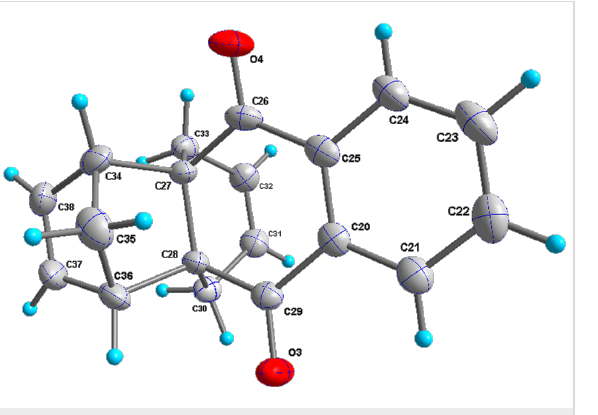
Figure 2: The molecular structure of 1a , with displacement ellipsoids drawn at the 50% probability level.